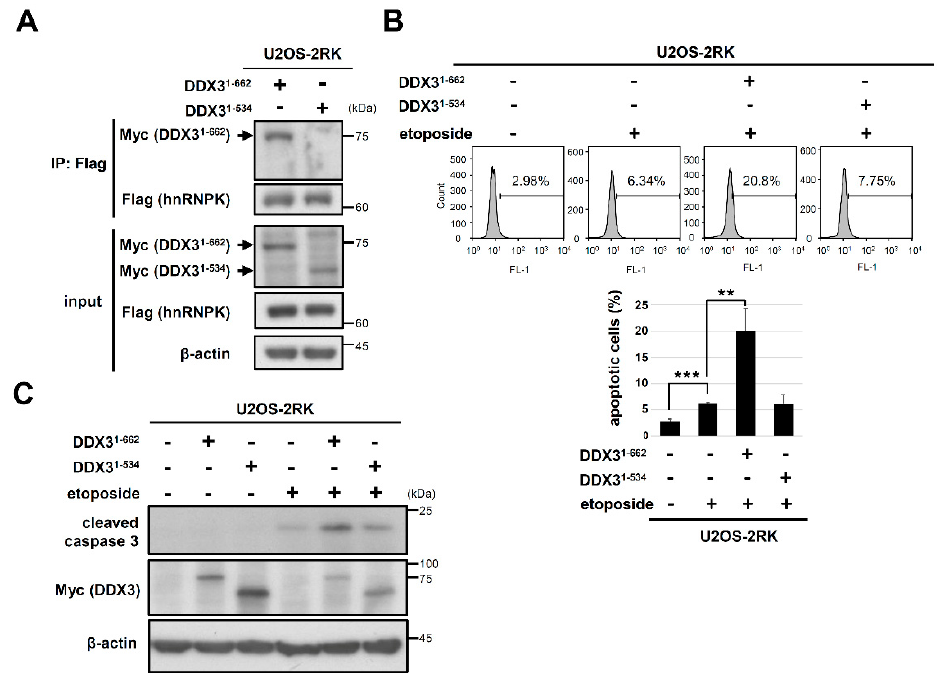
Figure 4. Truncation of the C-terminus in DDX3 diminished hnRNPK MD -mediated apoptosis upon DNA damage. ( A ) U2OS-2RK cells were transfected with either Myc-DDX3 1–662 or Myc-DDX3 1–534 for 48 h. Cell lysates were collected to meas- ure the interaction between hnRNPK and DDX3. ( B ) U2OS-2RK cells were transfected with either pcDNA4, Myc-DDX3 1– 662 , or Myc-DDX3 1–534 for 24 h and were then treated with etoposide (50 μ M) for another 12 h. Cell lysates were collected and analyzed by TUNEL assay to determine the degree of apoptosis using FACS (top). Quantitation of apoptotic cells in the TUNEL assay is shown ( b ottom). ( C ) Under the same treatment as described above, cell lysates were collected and analyzed for the expression levels of active caspase-3. ** as p < 0.01, *** as p <